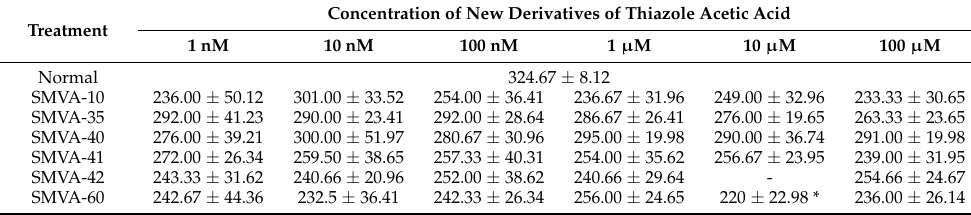
Table 2. Effects of new synthetic derivatives of thiazole acetic acid on the heart rate (beats per minute) in isolated rat